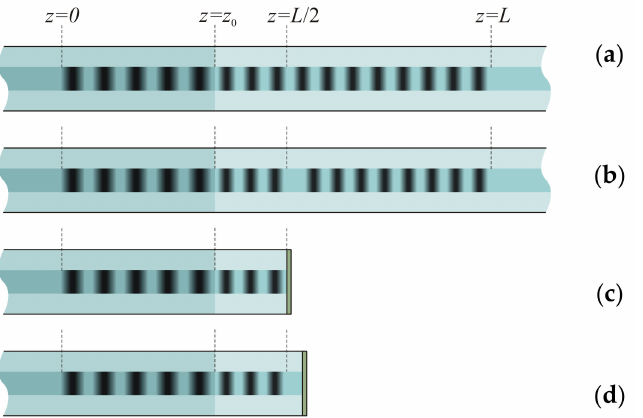
Figure 1. Scheme of LPFG structures deformed by an acoustic shock front: ( a ) homogeneous, ( b ) π -sift, ( c ) reflective, ( d ) reflective π